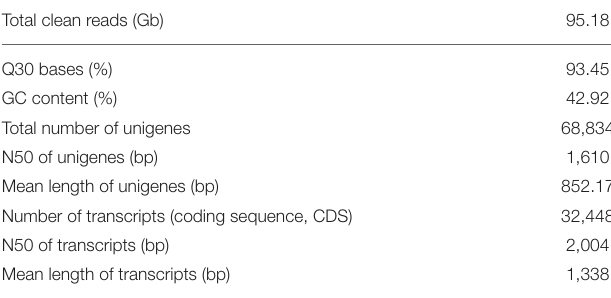
TABLE 1 | Summary of the transcriptome analysis of leaves in dormancy and non-dormancy alfalfa cultivars under lower